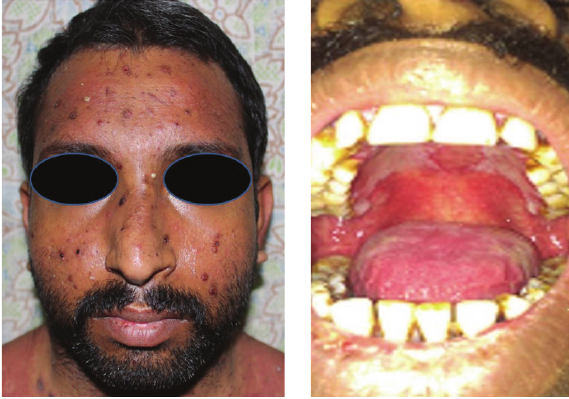
Figure 2: Pustules on face with mucositis in oral cavity (Case